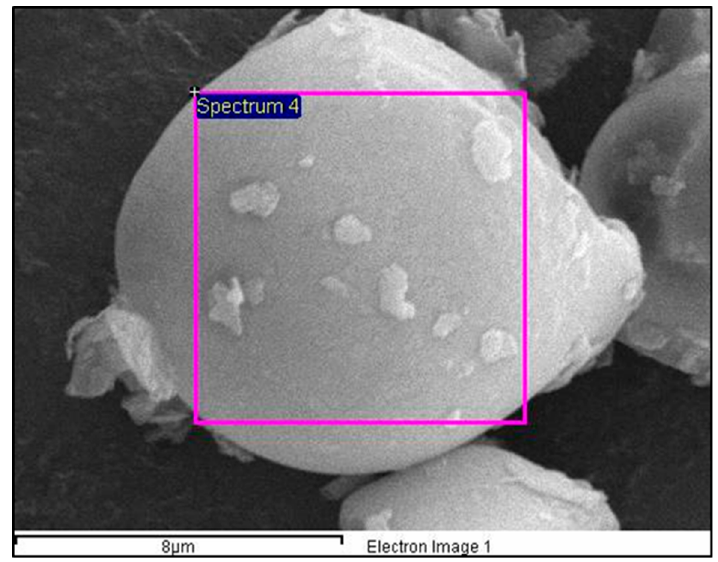
Figure 4. Scanning electron micrograph of cassava peel powder.